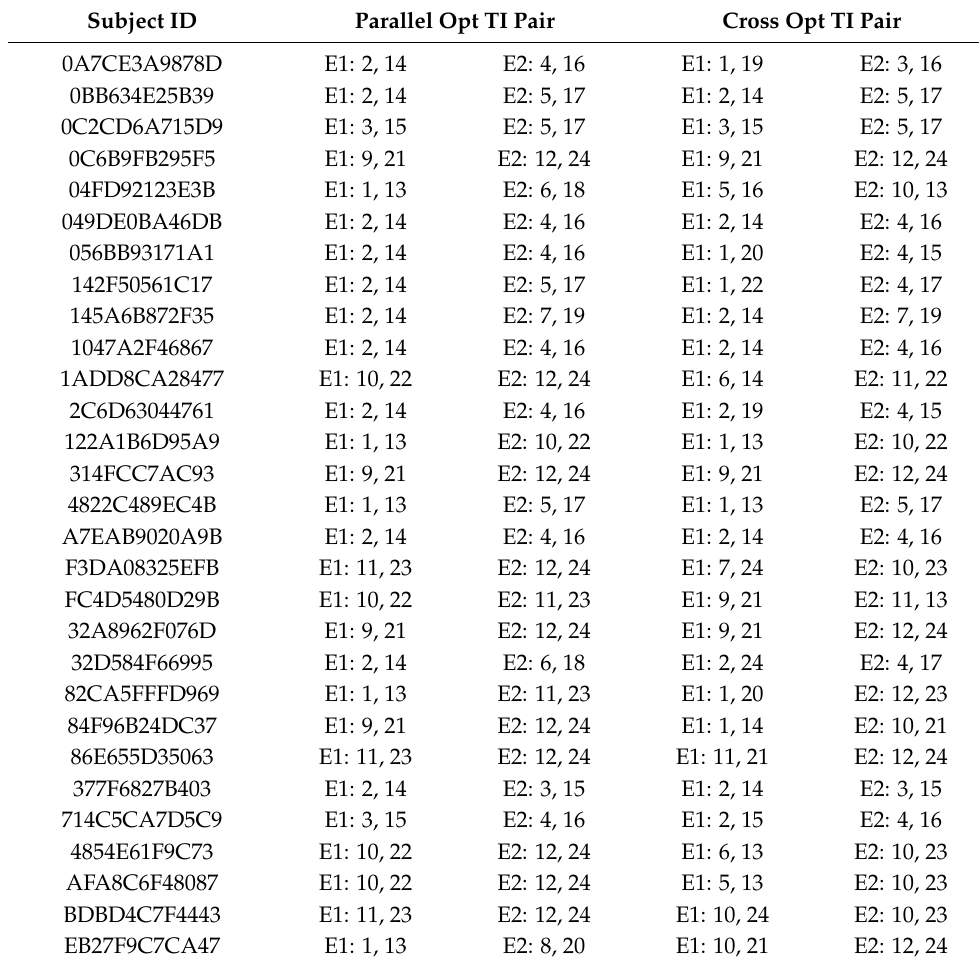
Table 3. Electrode pair differences between parallel opt and cross opt-in all